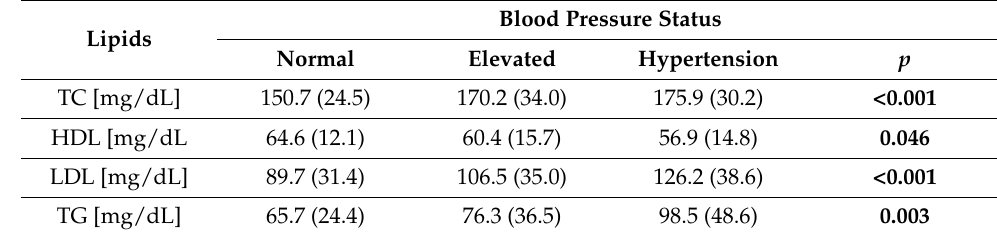
Table 7. Associations between lipid level and blood